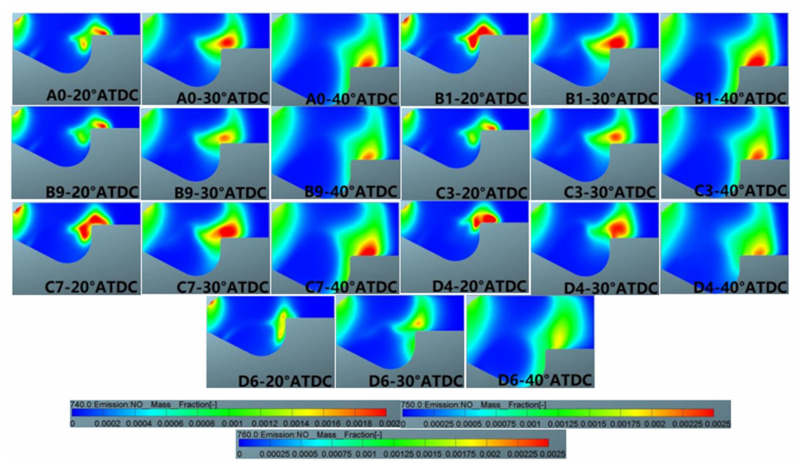
Figure 43. Map of the NO mass fraction